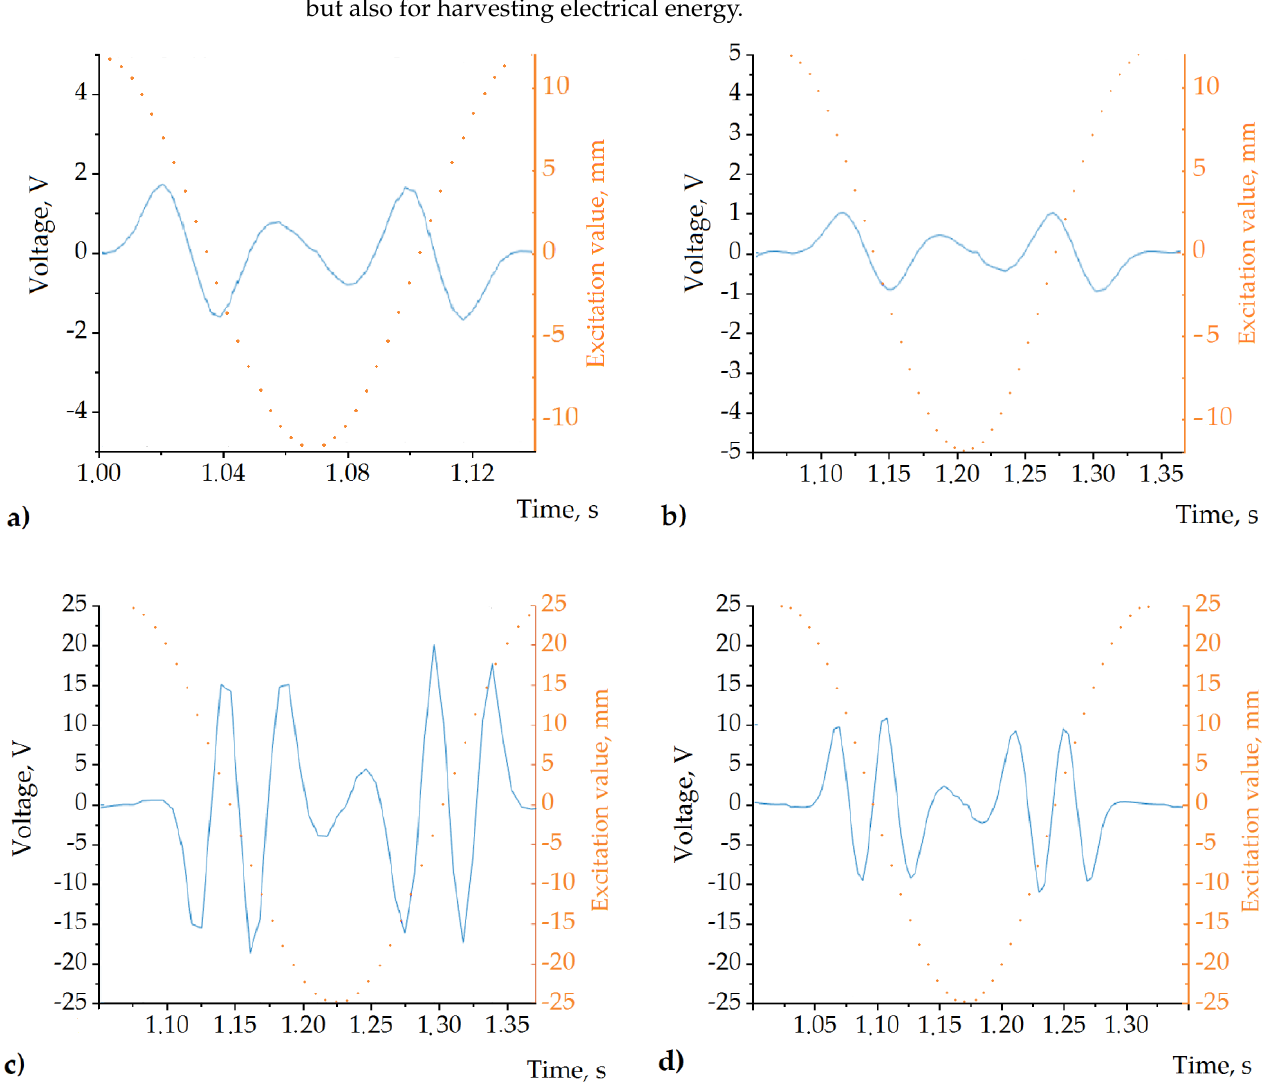
Figure 9. Results of the experiment. ( a ) Output voltage captured at 7 Hz and |𝑑| =12.5 mm. ( b ) Out- put voltage captured at 4 Hz and |𝑑| = 12.5 mm. ( c ) Output voltage captured at 7 Hz and |𝑑| = 25 mm. ( d ) Output voltage captured at 4 Hz and |𝑑| = 25 mm excitation. The dotted line schematically illustrates the excitation value at each time moment in all cases; it corresponds to the scale annotated on the right-side axis.